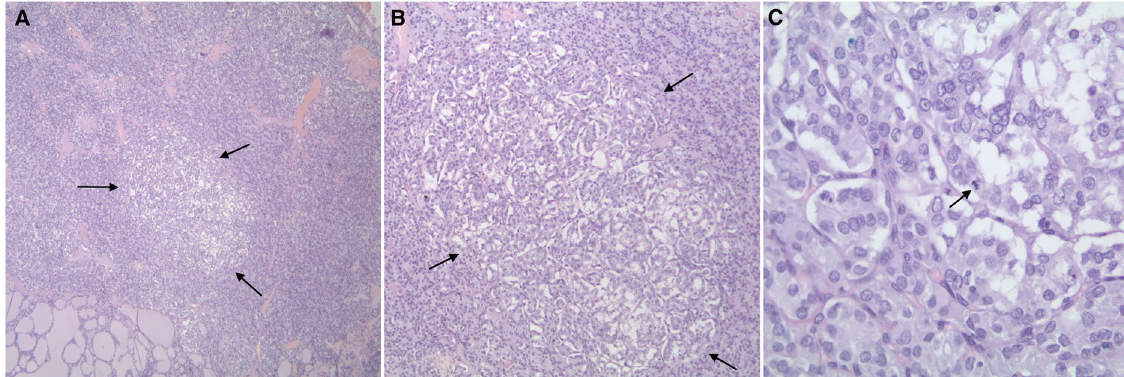
Figure 3. Histopathological examination of two PTC tissues. H&E staining (x100) shows A case of multifocal PTC-FV with a PTMC-FV focus that was positive for the NRAS mutation. ( A ) and ( B ) Note that the microscopic focus was unencapsulated ( arrows, 40x and 100x ). ( C ) Note the follicular architecture, irregular nuclei with clearing and grooves with a mitotic figure ( arrows, 400x ).